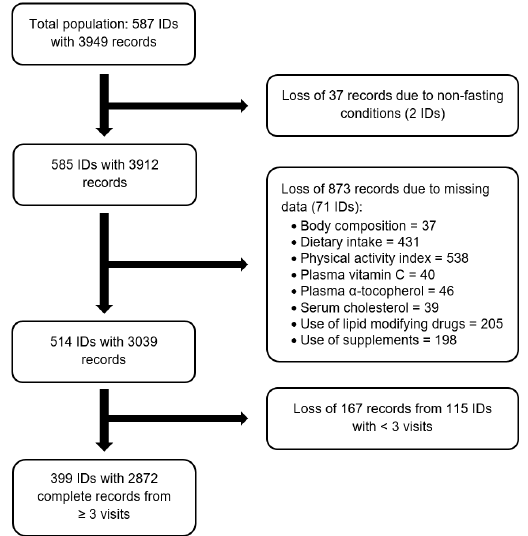
Figure 1. Flowchart. This flowchart illustrates the numbers and reasons for excluding subjects (indicated by IDs) and / or records. In total, 587 subjects participated in the GISELA study from 1994 to 2014. After applying the illustrated exclusion criteria, the final sample size for the present investigation was 399 subjects who had complete data records on relevant parameters on at least three visits during the study